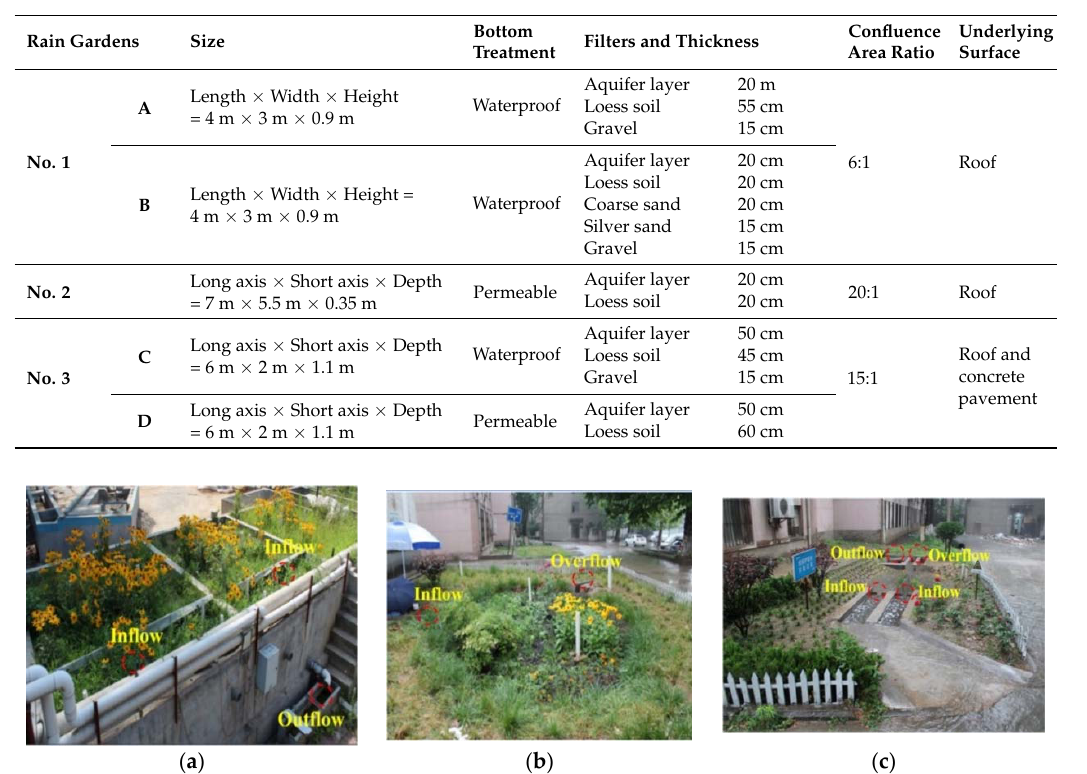
Table 1. The overall situation of rain garden.